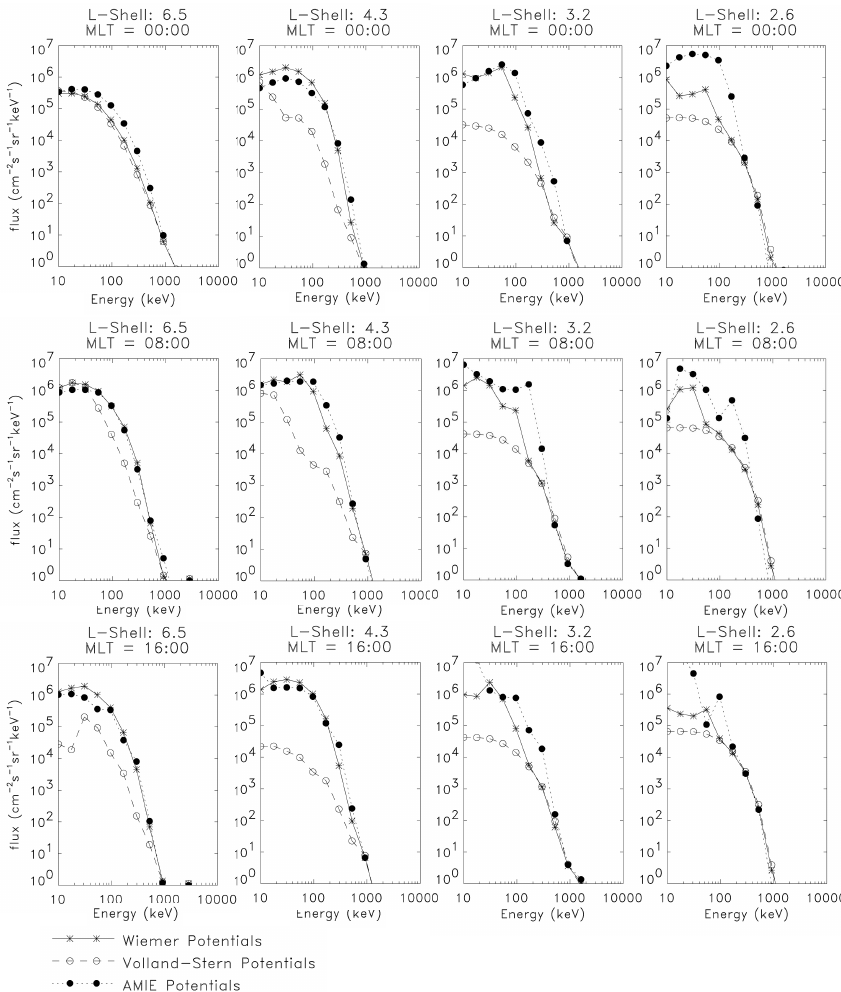
Fig. 8. Same as Fig. 5 except for electrons at hour 80 (08:00 UT, end of the main